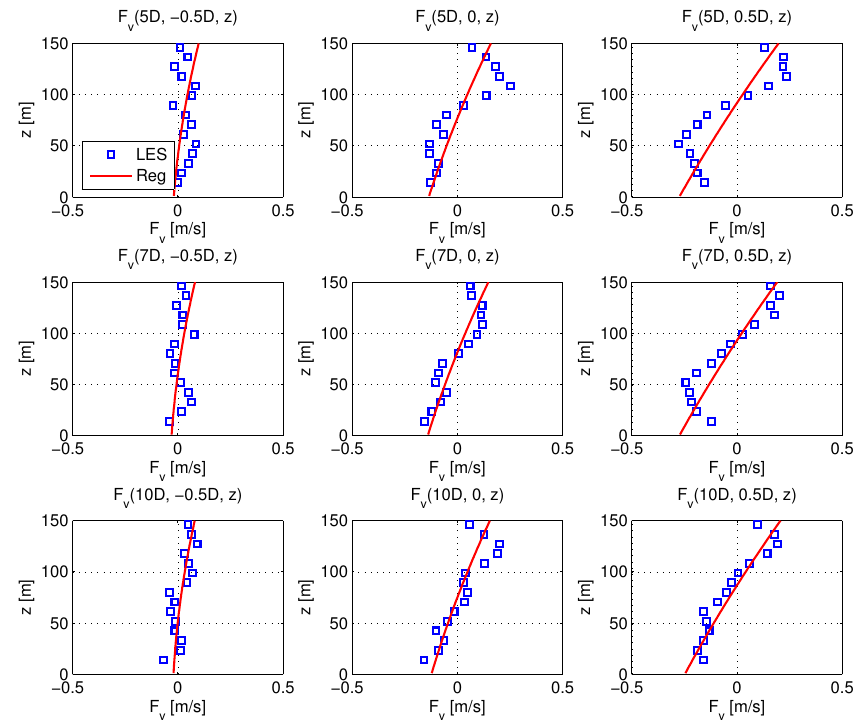
Figure 19. Spatial variation of F v : LES versus regression-based estimation.